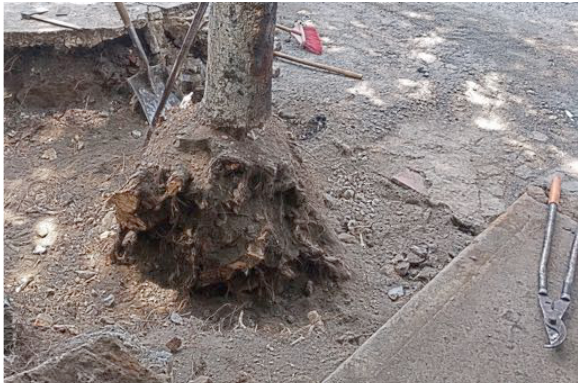
Figure 3. Root mutilated from maintenance works performed from a non-specialized informal contractor. Principal roots were cut and root anchoring lost as the specimen, Liquidambar styraciflua or Sweetgum, develops surface or lateral roots and "severing one major root … may kill up to 25 percent of the tree root system" (Shamoon, 2012). The tree was removed next day due to severe instability.